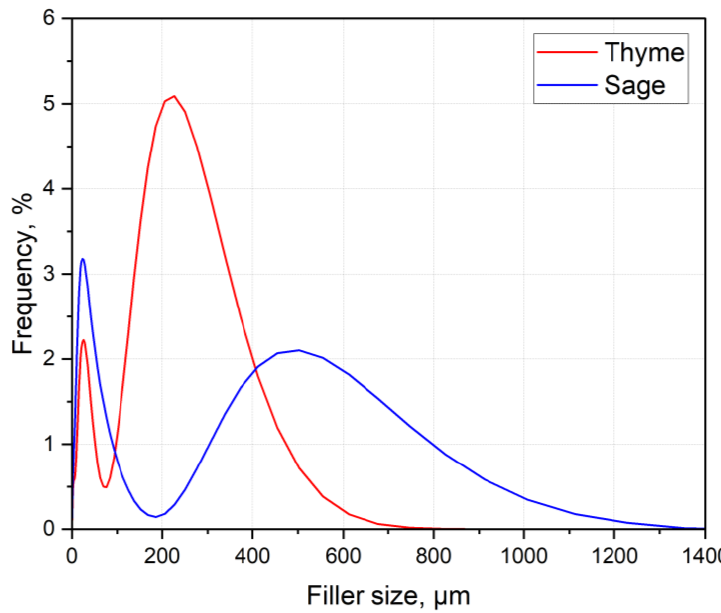
Figure 6. Particle size distribution of the fillers’ grains.